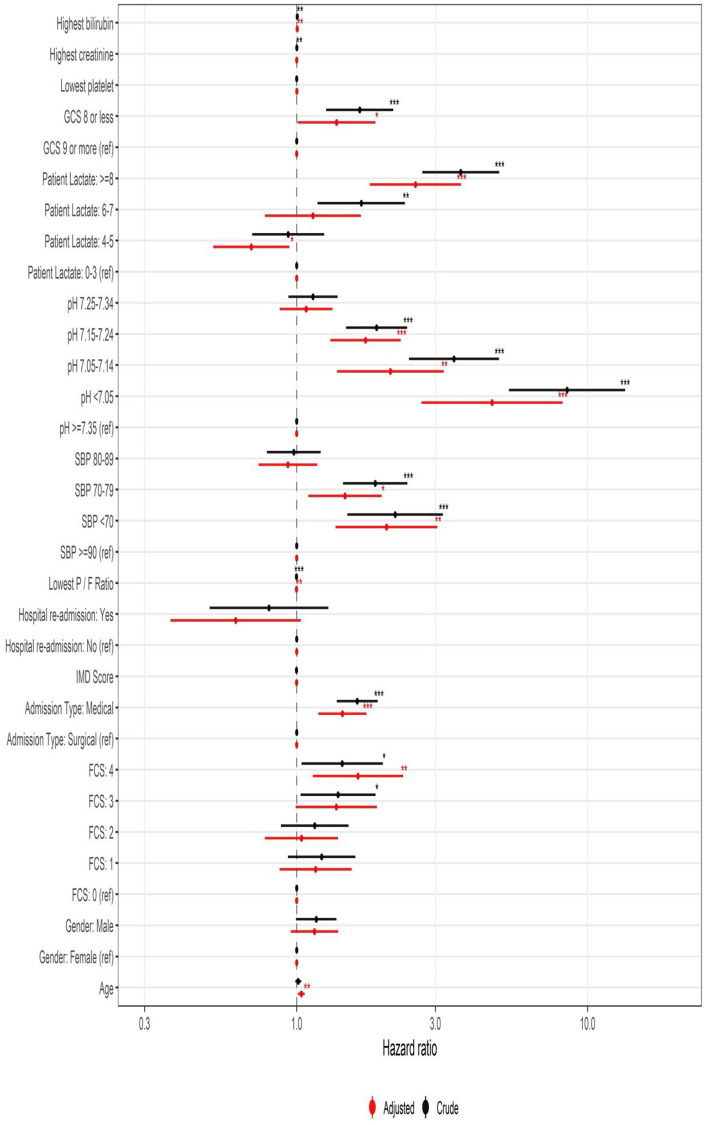
Adjusted and crude hazard ratios showing the effect of physiological variables and patient characteristics on survival.